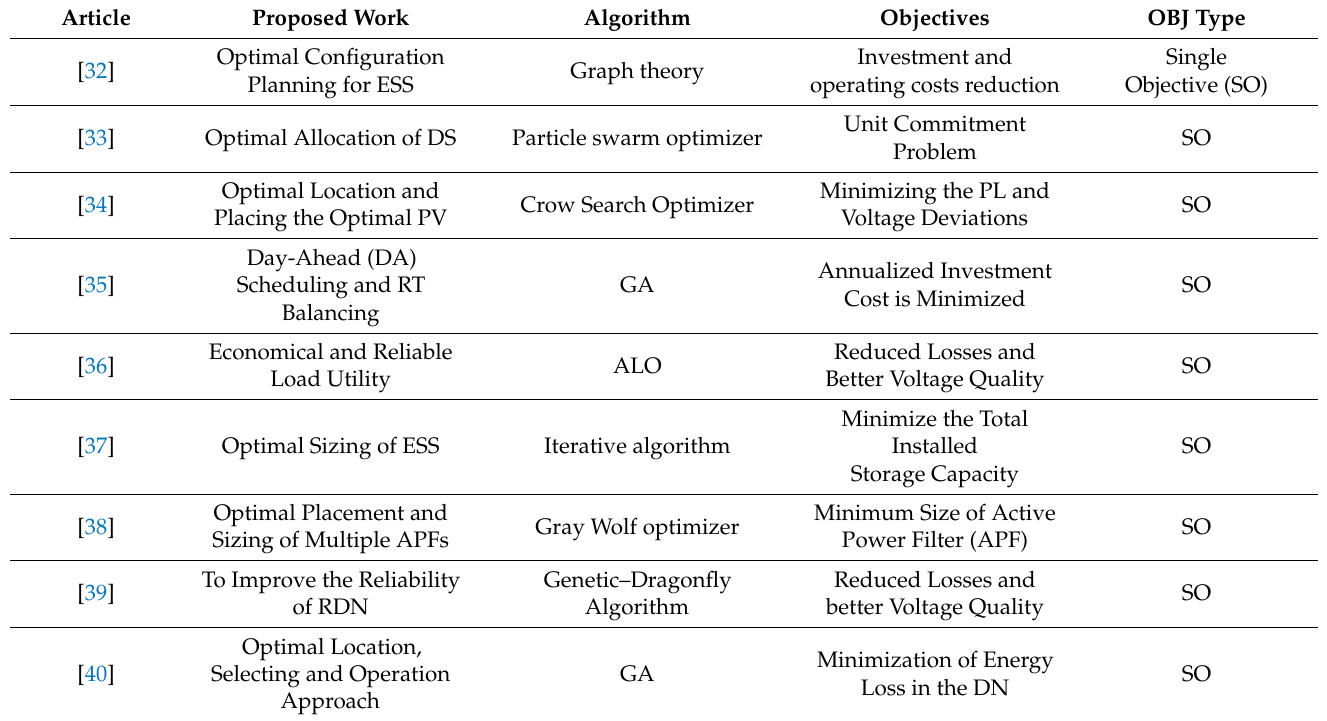
Table 1. Overall analysis of the